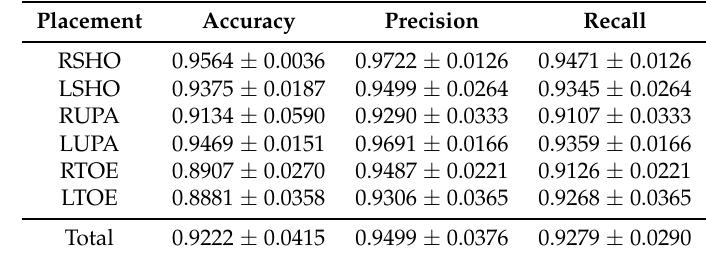
Table 1. Results of the automatic labeling when compared with the manual labeling (RSHO, Right Shoulder; LSHO, Left Shoulder; RUPA, Right Upper Arm; LUPA, Left Upper Arm; RTOE, Right Toe; LTOE, Left Toe).